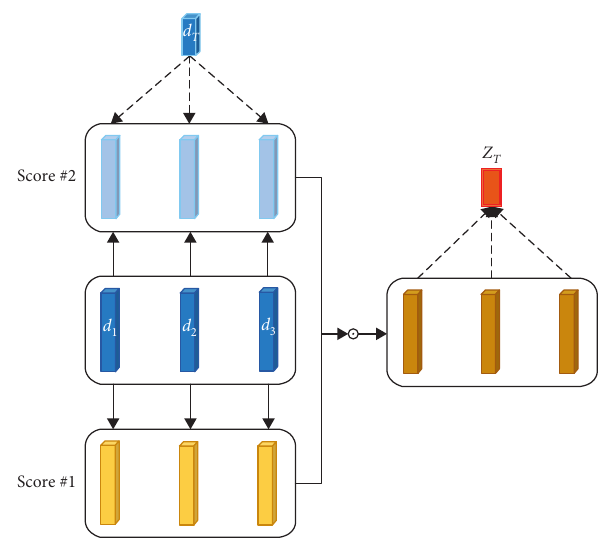
Figure 2: The architecture of temporal